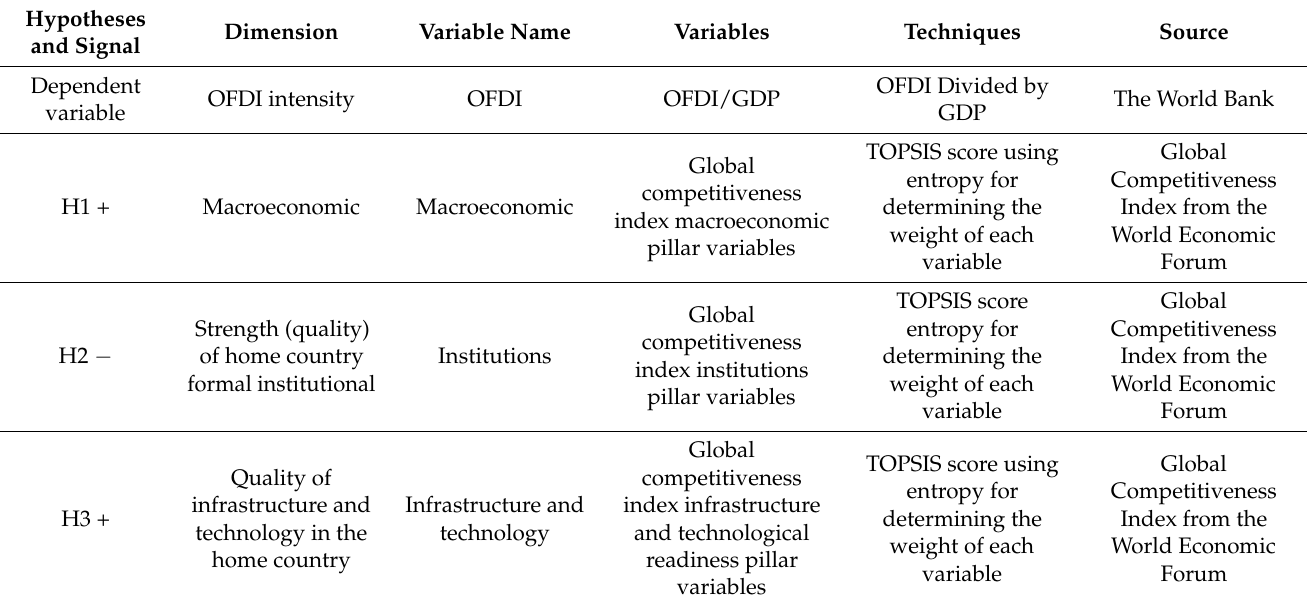
Table 2. Hypotheses, variables, dimensions, data sources, and techniques.